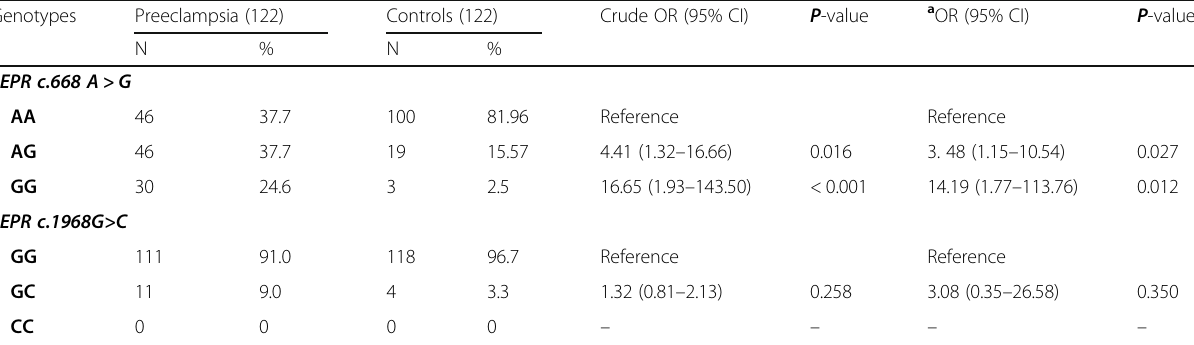
Table 2 Comparing the genotypes and alleles of LEPR c.668 A > G (Q223R) and LEPR c.1968G>C ( K656N) between women with preeclampsia and the